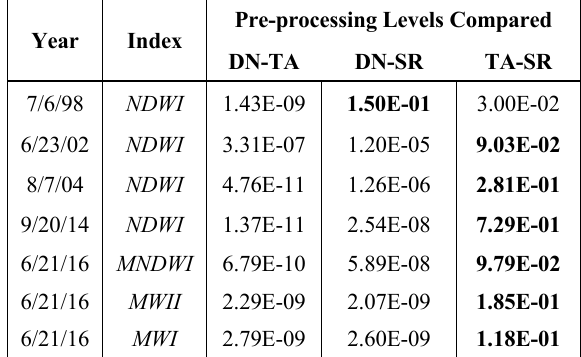
Table 2. P-values from years that exhibited an insignificant difference (p >0.05) between select indices calculated from DN, TA, and SR pre-processing levels for shallow water. Bold numbers denote insignificant p-values.